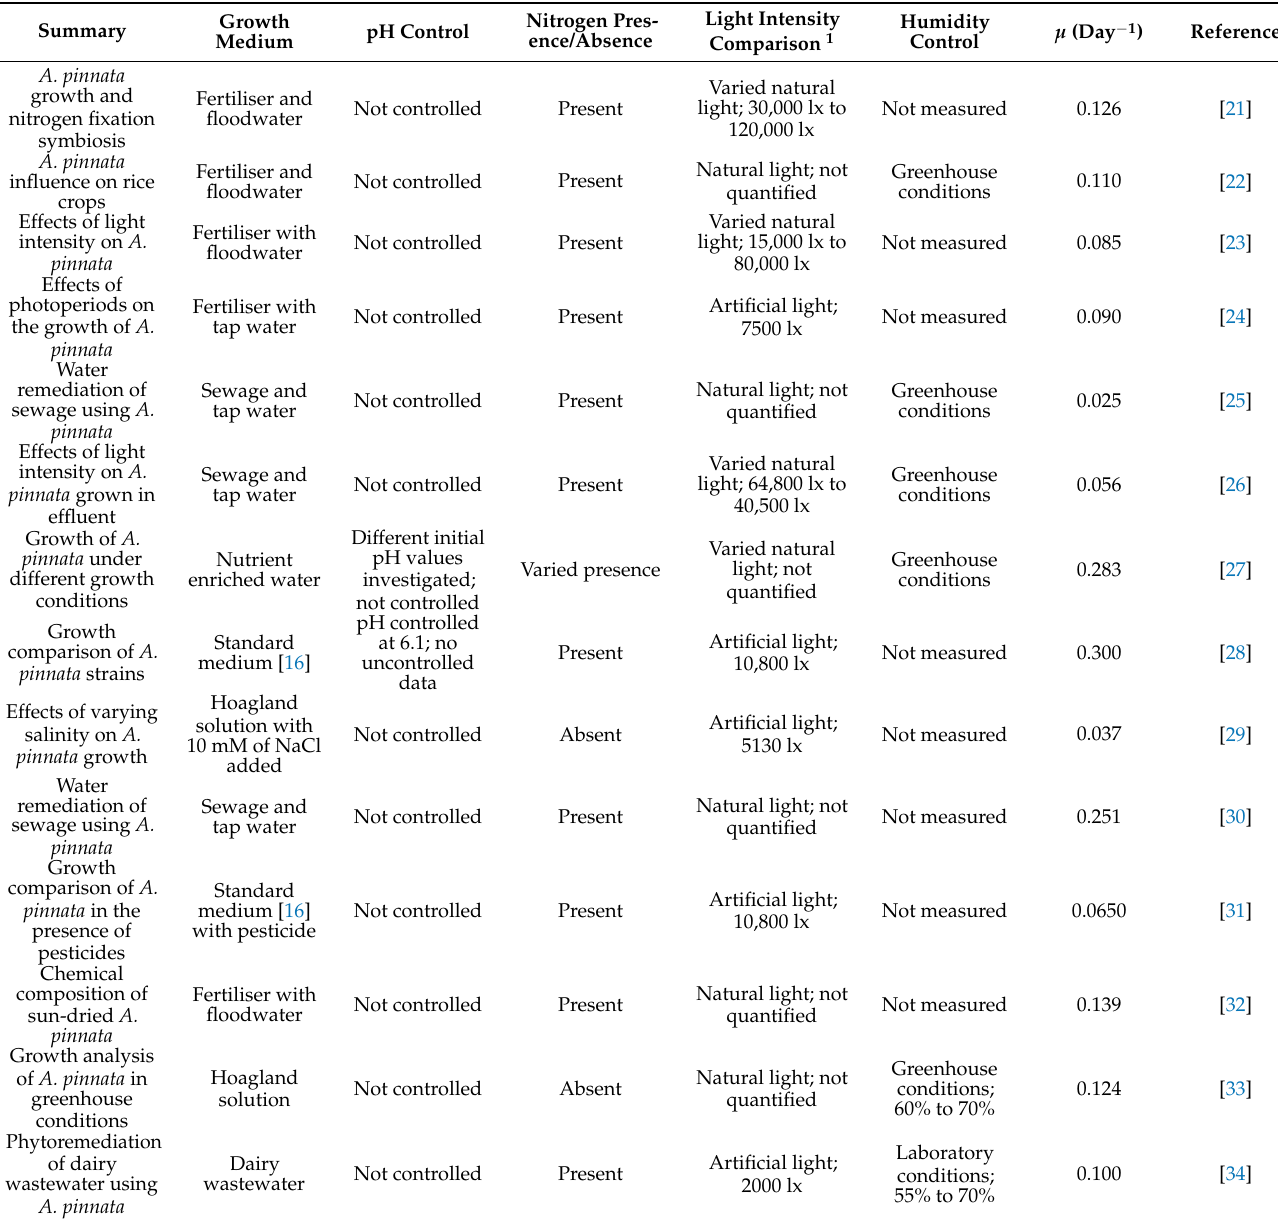
Table 1. A literature comparison of studies that recorded the growth of A. pinnata under different growth conditions. A summary of the aims of each paper is provided. The growth medium, pH control, presence of nitrogen, light intensity, and humidity control are all noted. The average specific mass-based growth rate µ (day − 1 ) that was reported in each study is also